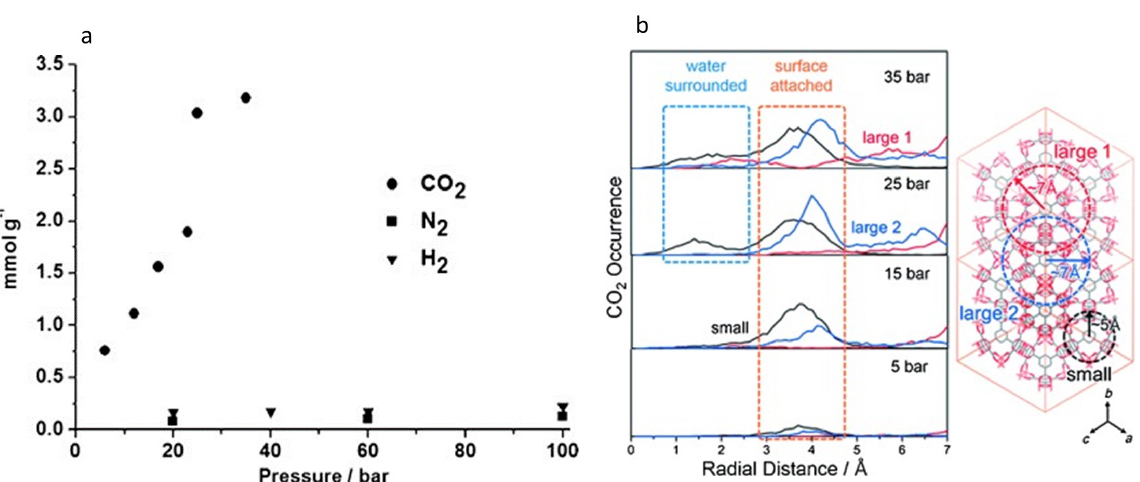
Figure 8. HKUST ‐ 1 ‐ based CO 2 gas stored under hydrate formation conditions: ( a ) Gas storage (mmol/g) of water ‐ saturated HKUST ‐ 1 at different pressures; ( b ) Spatial distributions of CO 2 along the radial direction from the center of three different pore types (one small pore and two large pores) (Reprinted from [36], copyright (2015) with permission from WILEY ‐ VCH Verlag GmbH & Co. KGaA, Weinheim).